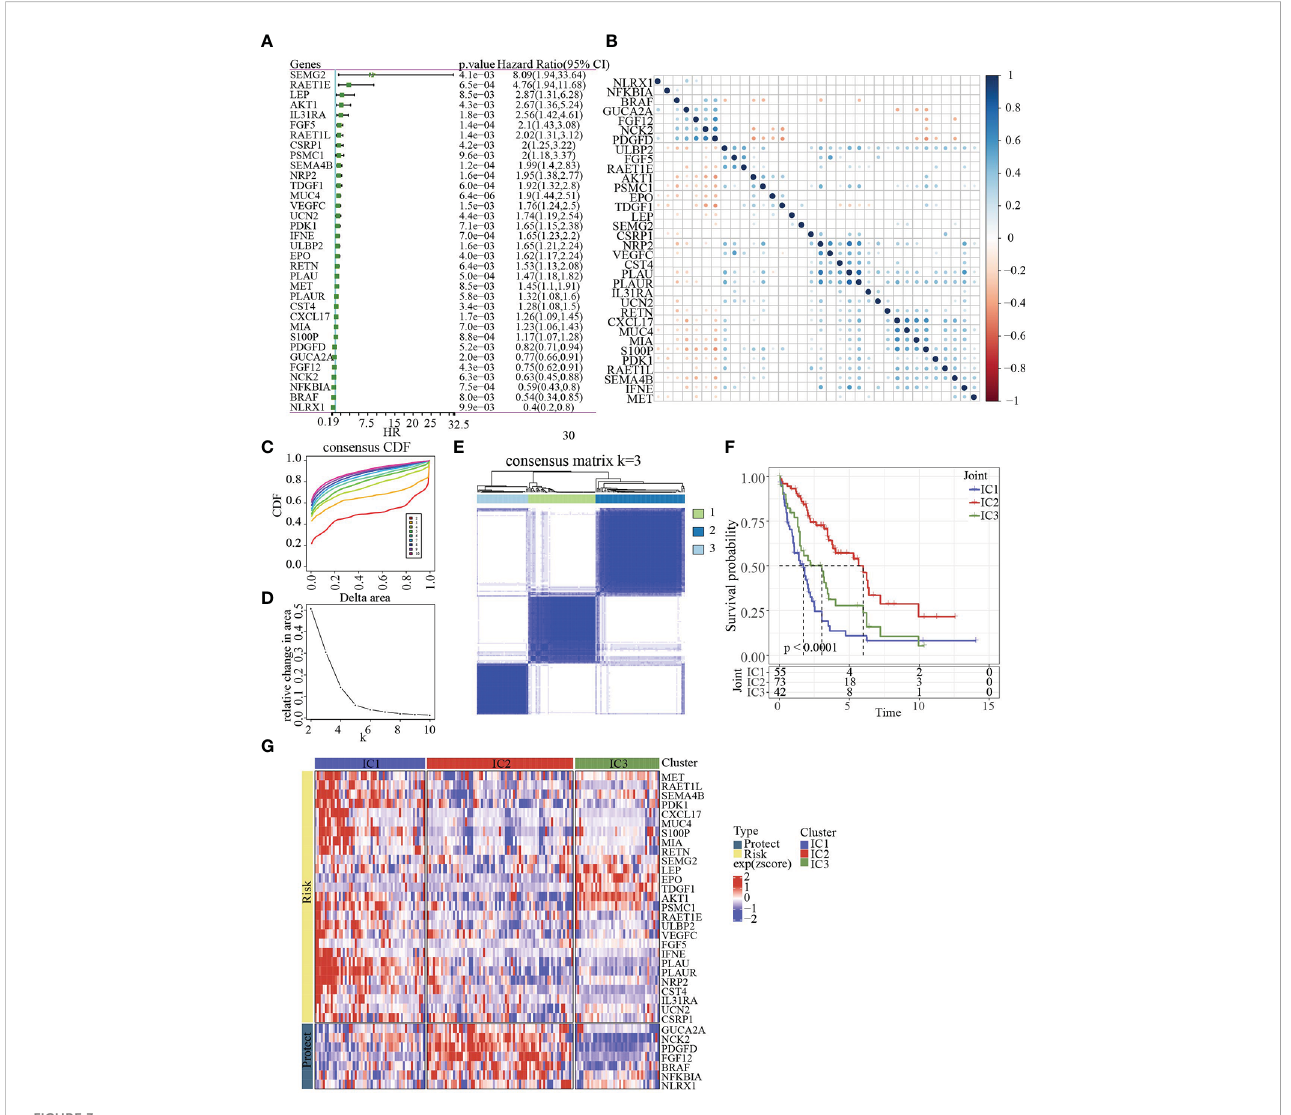
FIGURE 3 Identi fi cation of molecular subtypes. (A) Forest map of immune genes with signi fi cant prognosis analysed by univariate Cox regression. (B) Pearson correlation analysis of immune genes associated with prognosis. (C) Cumulative distribution function. (D) Delta area of Cumulative distribution function. (E) Clustering heatmap of samples in Joint data when k=3. (F) KM prognosis curve of 3 molecular subtypes. (G) Heatmap of immune genes associated with prognosis in 3 molecular